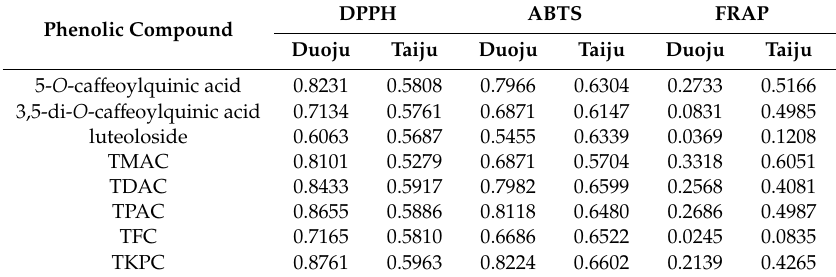
Table 6. Correlation index ( R 2 ) between phenolic compounds and antioxidant activities in di ff erent